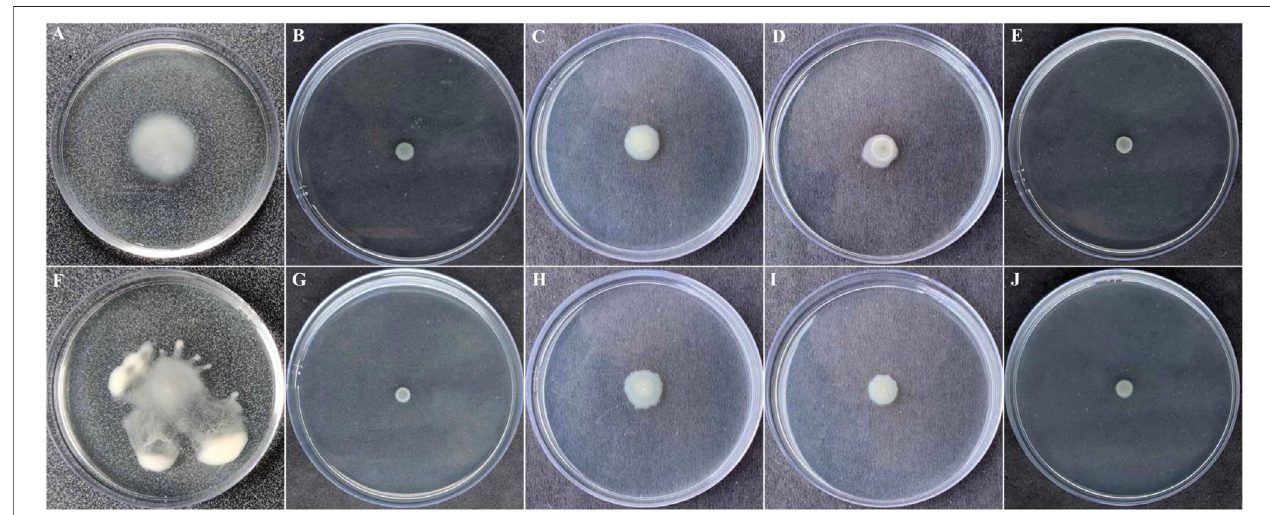
FIGURE 7 | Swimming (A – E) and swarming motilities (F – J) . Different treatment given DMSO (A,F) , and salicylic acid (B,G) as positive control and BG138 varying concentrations 8 μ g/ml (C,H) , 12 μ g/ml (D,I) , and 16 μ g/ml (E,J) .